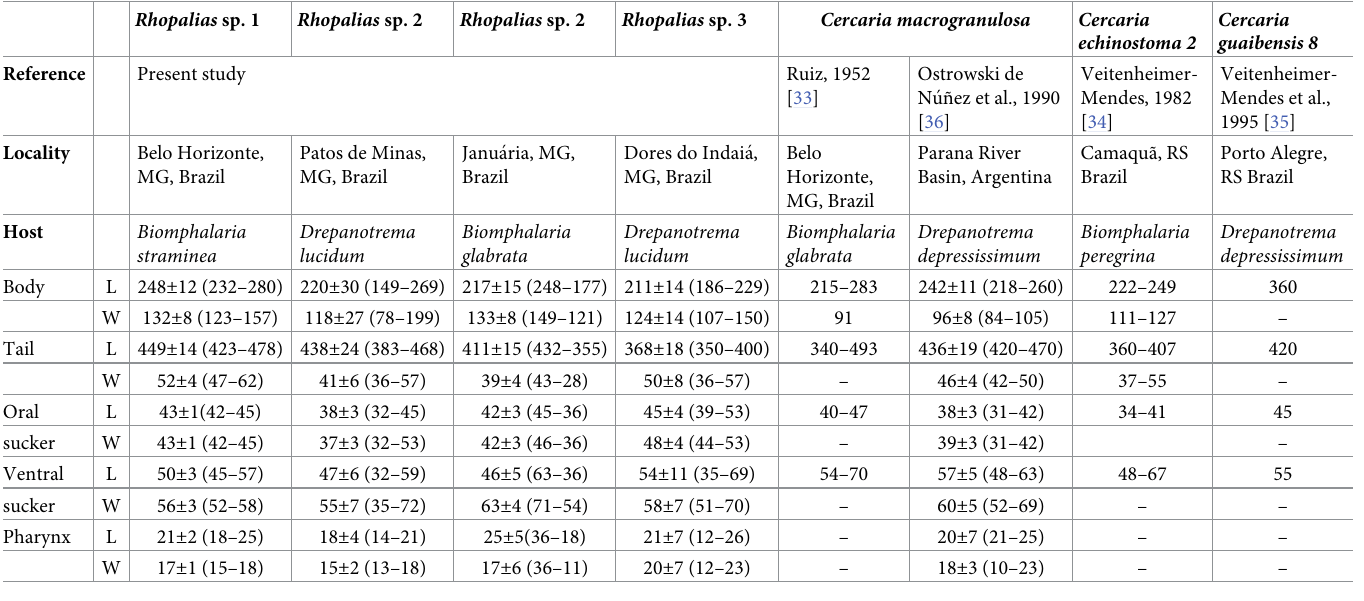
Table 3. Morphometric data of larval stages of Rhopalias spp. examined in this study, and other unspined echinostome cercariae described in South America by dif- ferent